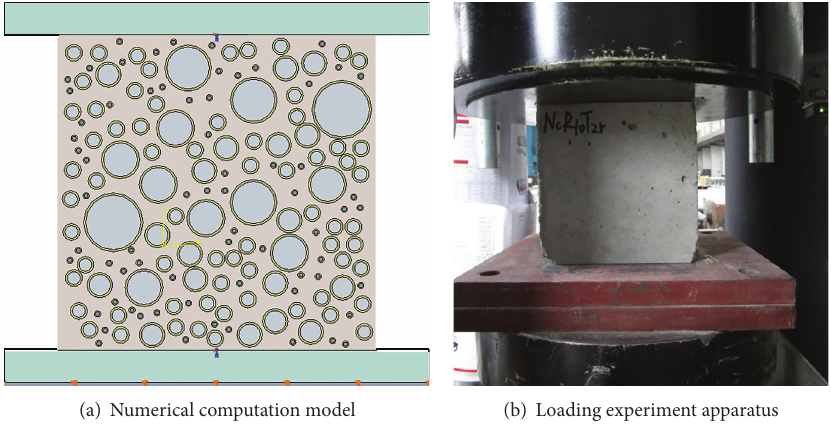
Figure 4: Uniaxial compression of concrete cubic standard test sample.